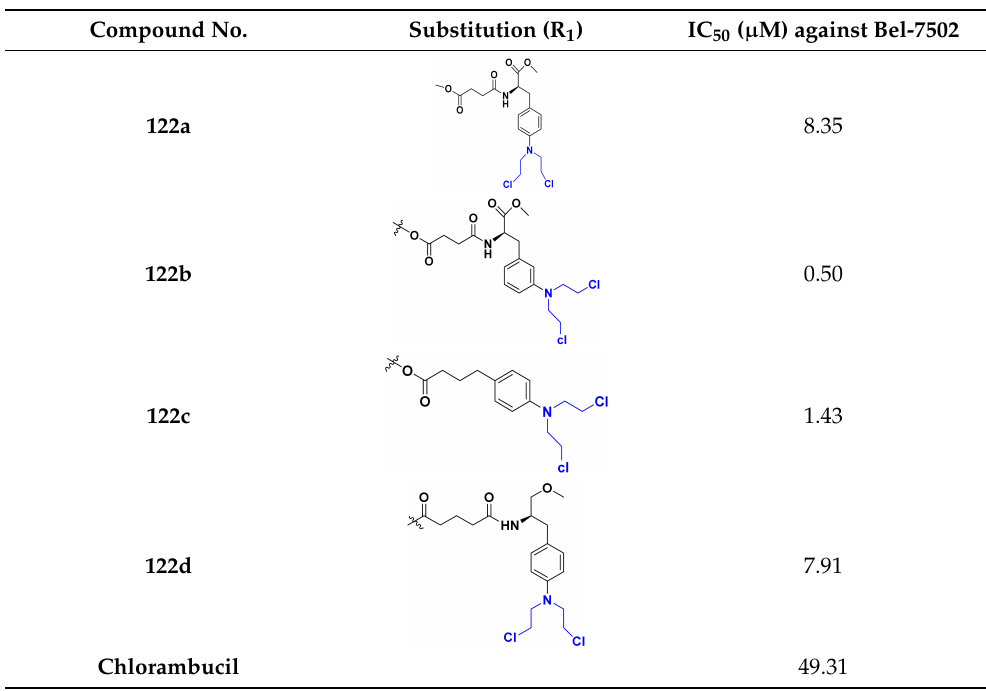
Table 103. In vitro cytotoxic activities of nitrogen mustard-containing oridonin hybrid compounds 122 ( a – d